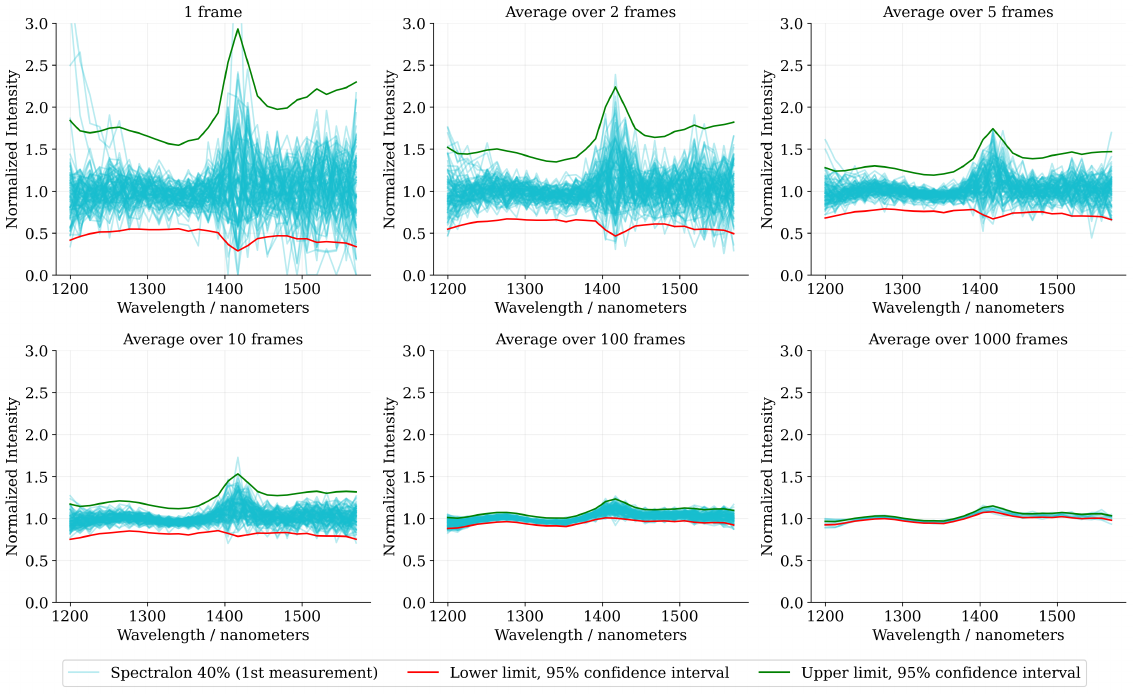
Figure 14. The relative spectral reflectance curves of Spectralon 40% sample, along with the theoretical 95% confidence intervals for various block sizes. Each subplot visualizes 100 sample spectra, except the last one with block size of N frames = 1000, which visualizes 10 sample spectra. The confidence intervals were calculated by estimating the average photon count over the whole sample sequence of 10,000 consecutive